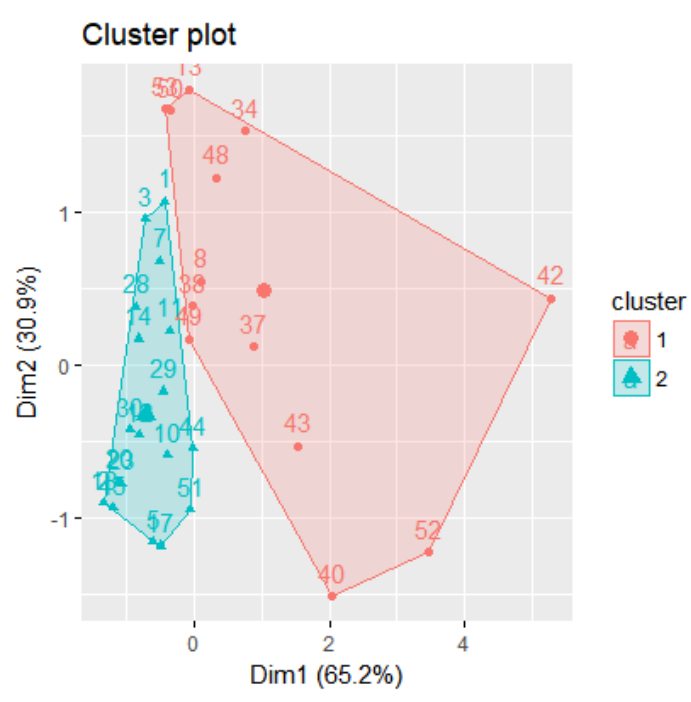
Figure 2. K-means clustering model results for k =